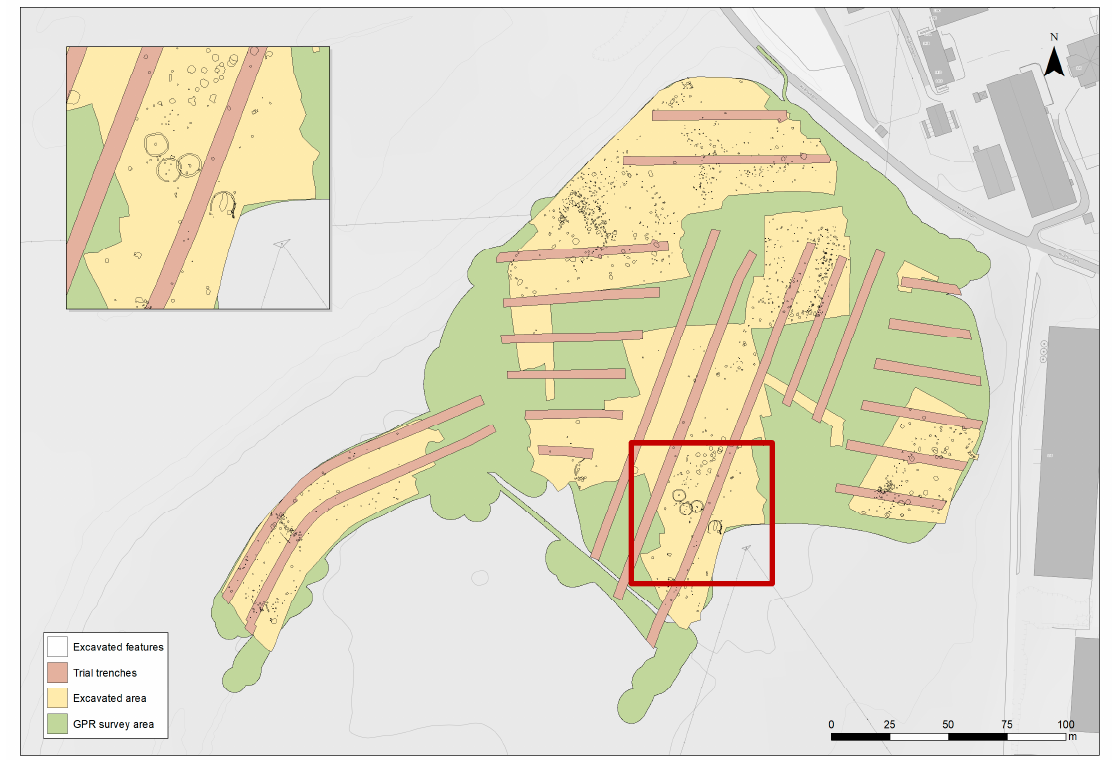
Figure 5. Map showing the extent of trial trenches, GPR survey areas, and topsoil stripping at Øya. Map source: The NTNU University Museum, Trøndelag county council, The Norwegian Mapping Authority, Geovekst and Municipalities,